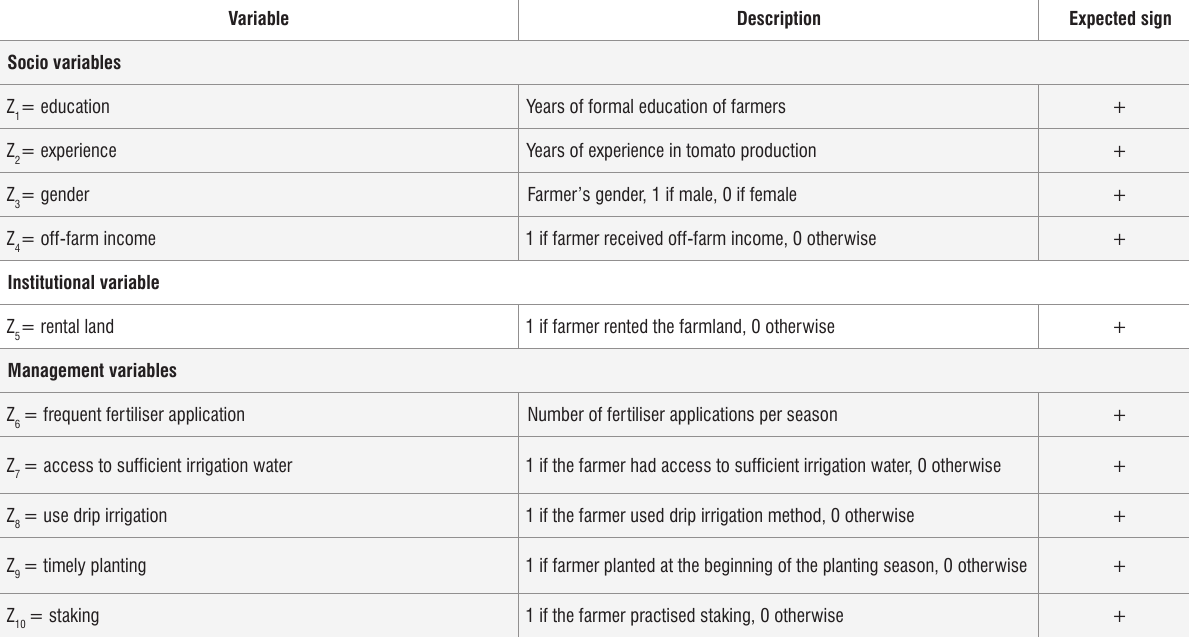
Description of the production variables and their expected signs